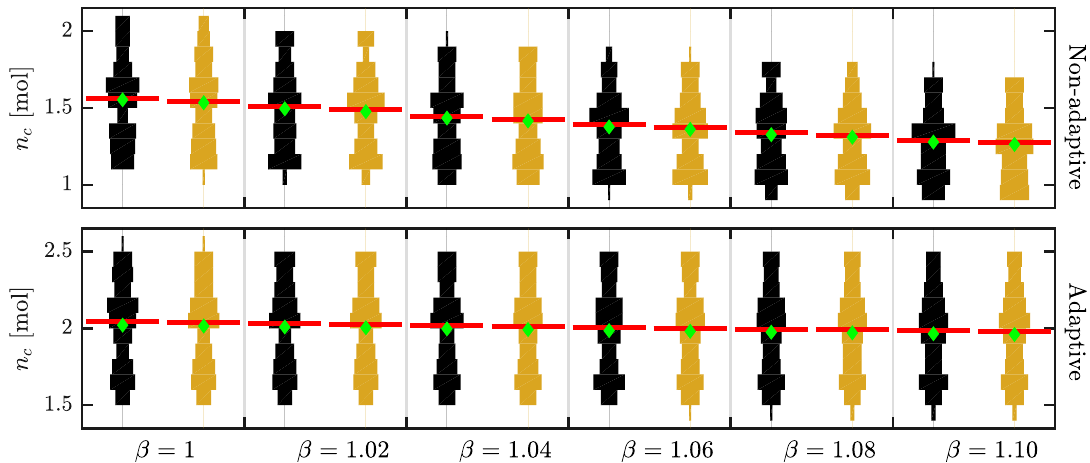
Figure 12. Violin plot of the amount of product C produced during the first 0.3 h using MS-SB, A-MS-SB, MS-CB, and A-MS-CB NMPC schemes with different values of the scaling increase factor ( β ) in the absence of measurement noise. represents MS-SB NMPC, A-MS-SB NMPC, and represents MS-CB NMPC, A-MS-CB NMPC. and represent the mean and median